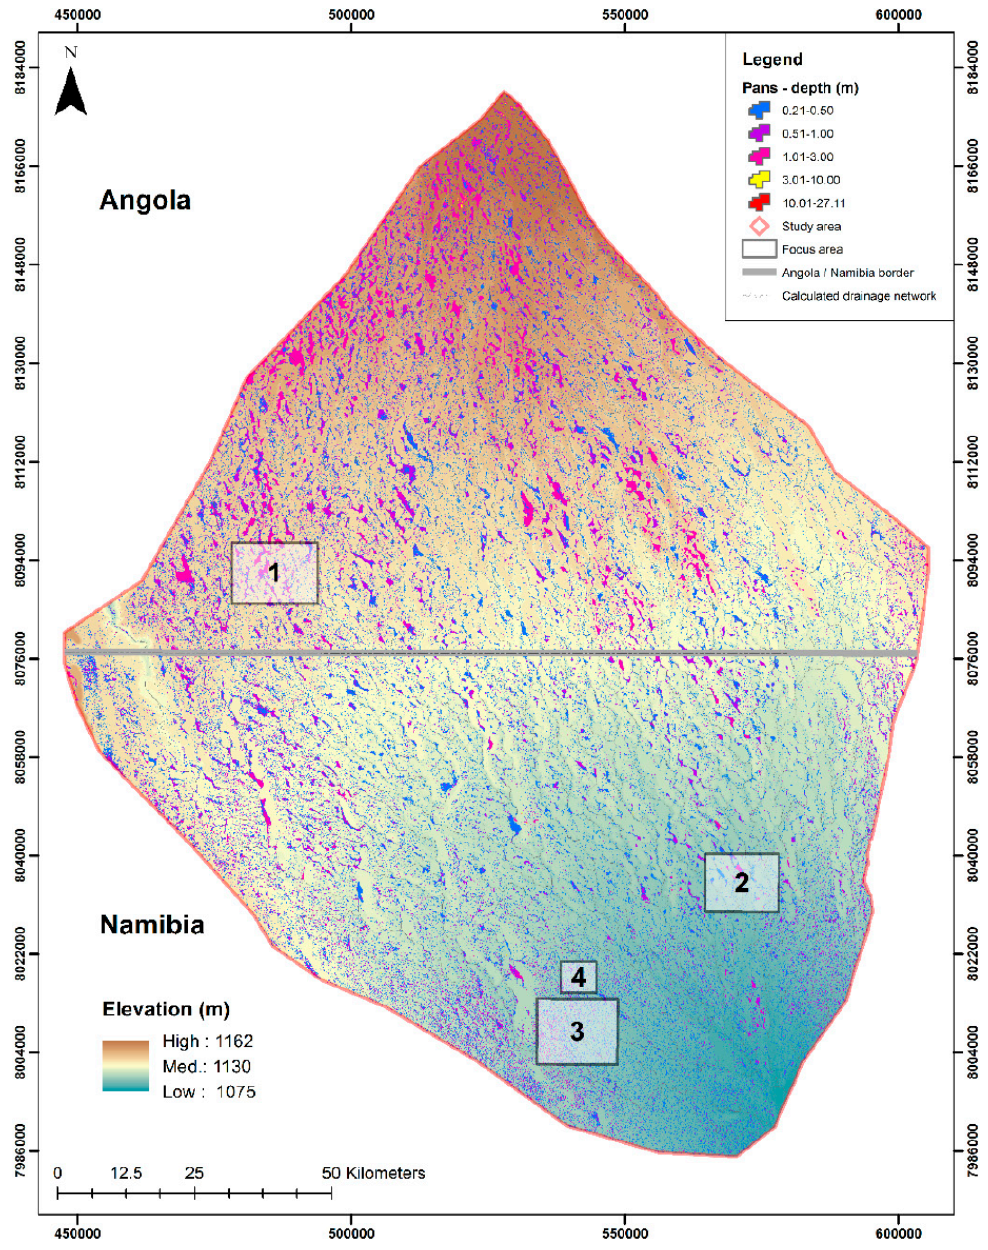
Figure 6. Pans and their depths in meters for the entire transboundary Iishana-System. Detailed information for focus areas 1–3 can be found in Figure 7. Focus area 4 represents the example for validation and is shown in Figure